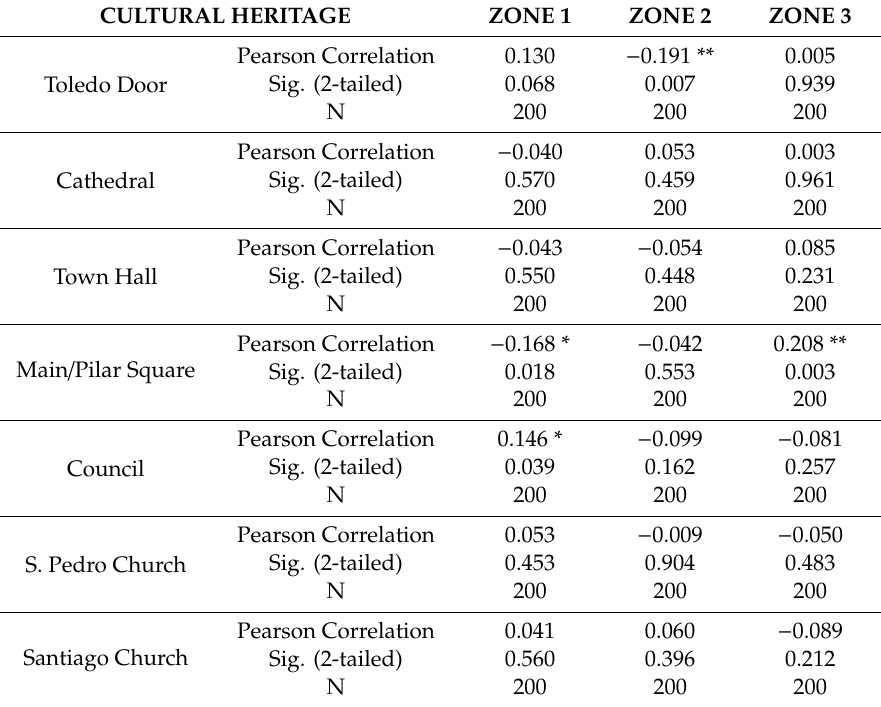
Table 2. Correlation results between di ff erent zones and cultural